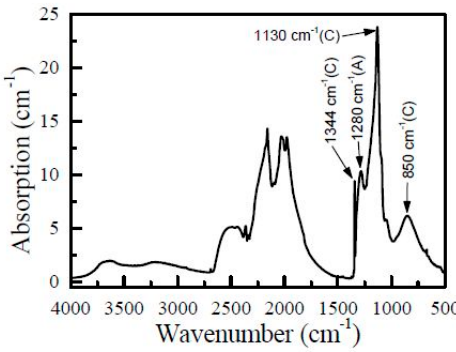
Figure 4. A representative infrared absorption spectrum of the diamond sample used in the study. The main absorption features related to the C- and A-centers are indicated.